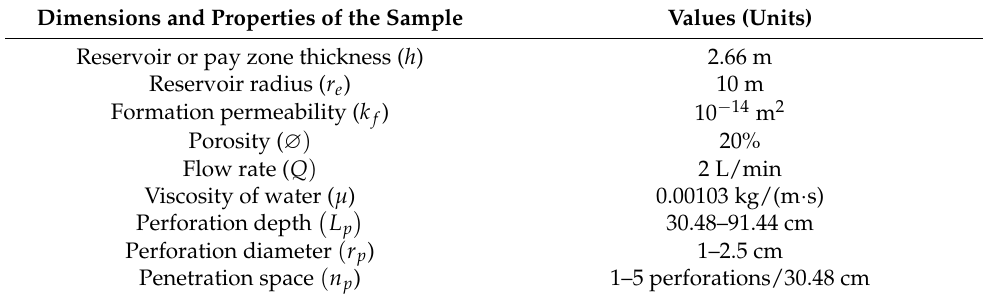
Figure 5. Schematic of inclined and completely perforated well with perforations perpendicular to well and formation damage. Table 1. Dimensions and properties of the vertical near-wellbore region and the ranges of three investigated parameters.